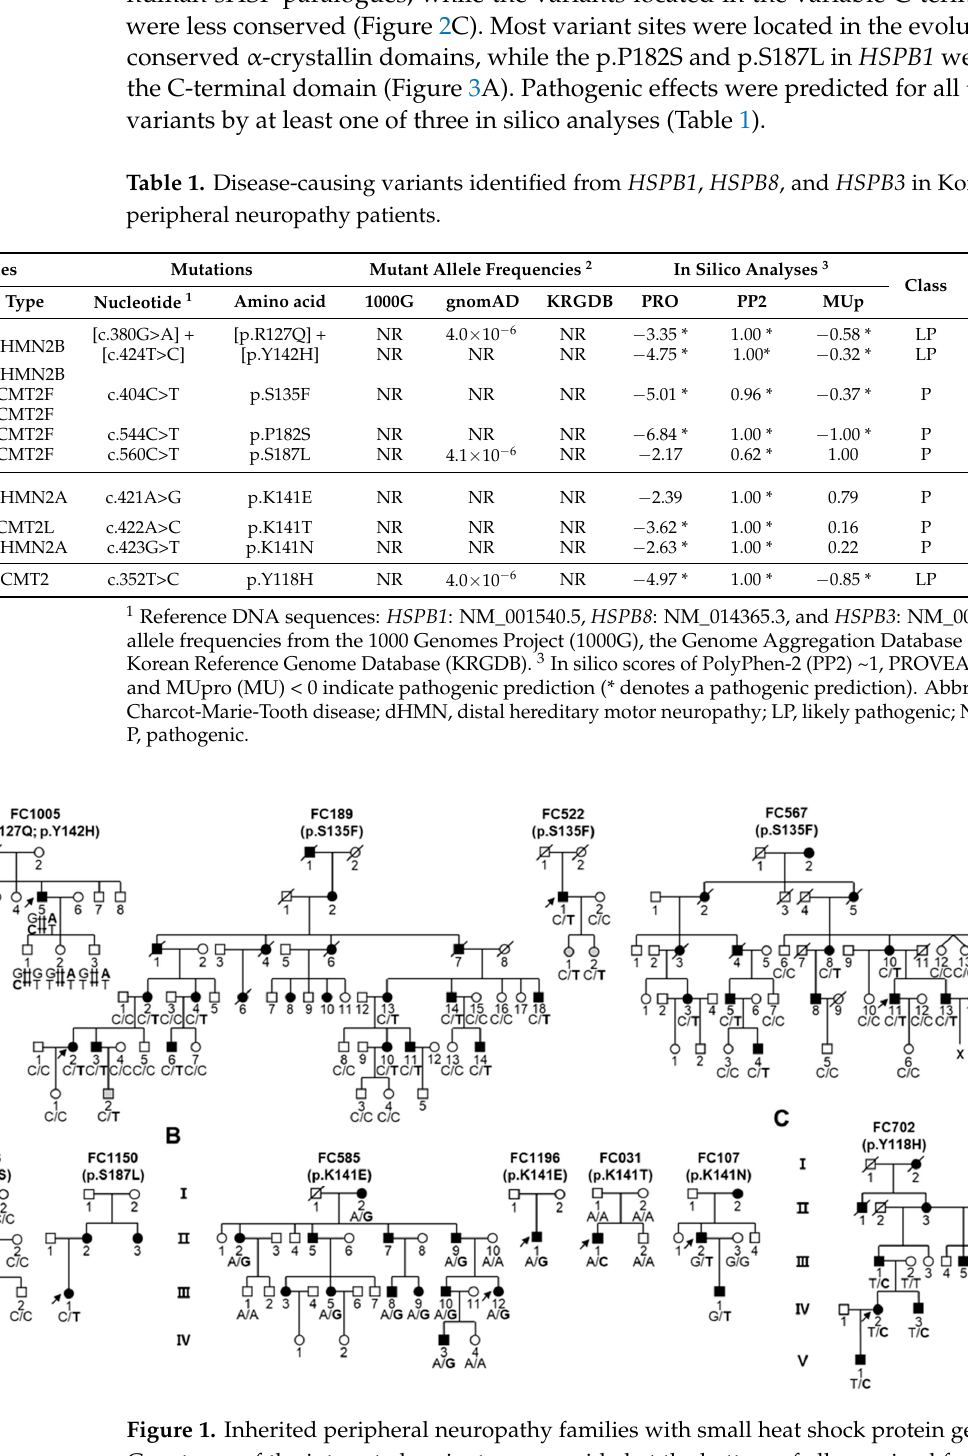
Figure 2. Mutations in three small heat shock protein genes. ( A ) Chromatograms of the mutation sites. They were obtained by Sanger sequencing. Vertical arrows indicate the mutation sites (WT: wild type allele, Mut: mutant allele). ( B ) Conservation of amino acids in the mutation sites (red) and vicinant sequences. Reference sequences are: NP_001531.1 ( Homo sapiens ), XP_519162.3 ( Pan troglo- dytes ), NP_038588.2 ( Mus musculus ), NP_990621.1 ( Gallus gallus ), NP_001072817.1 ( Xenopus tropi- calis ), NP_001008615.2 ( Danio rerio ), NP_001287001.1 ( Drosophila melanogaster ), NP_498776.1 ( Caeno- rhabditis elegans ) for HSPB1, NP_055180.1 ( H. sapiens ), XP_509417.1 ( P. troglodytes ), NP_109629.1 ( M. musculus ), XP_004934466.1 ( G. gallus ), NP_001005658.1 ( X. tropicalis ), NP_001094427.2 ( D. rerio ),